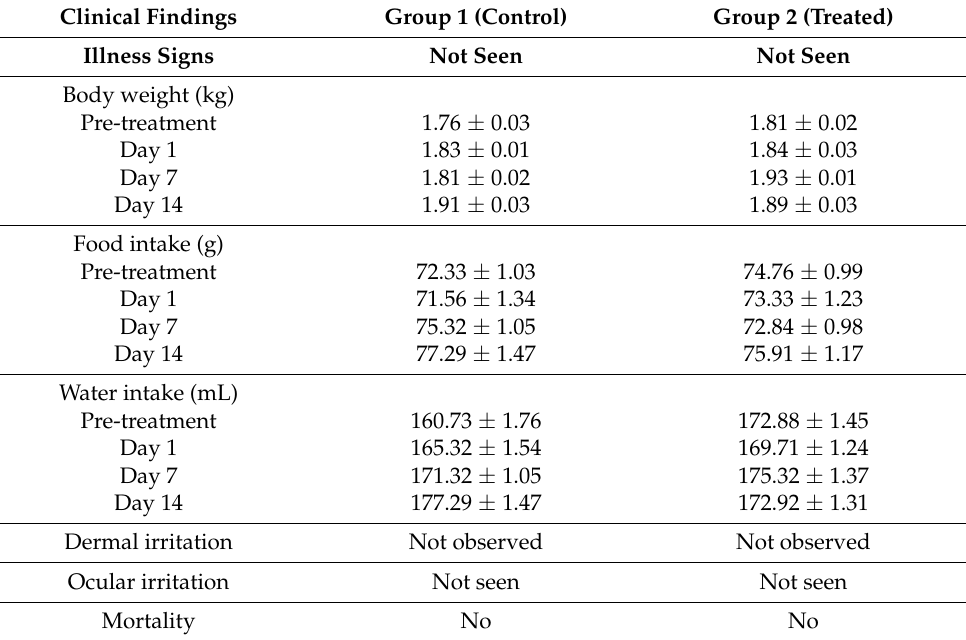
Table 4. Physical findings after administration of the developed Ins-Mmt-hydrogel NC (Mean ± S.D, n = 6).